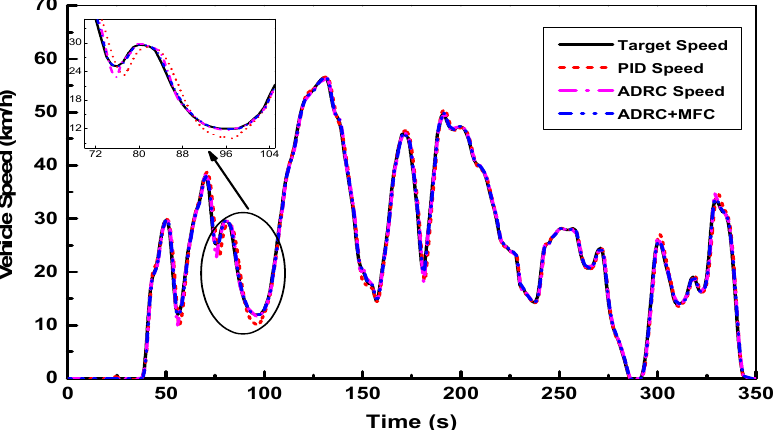
Figure 5. Speed tracking results for Case 1. Table 3. Tracking error statics with vehicle mass 1800 kg and incline 0°.